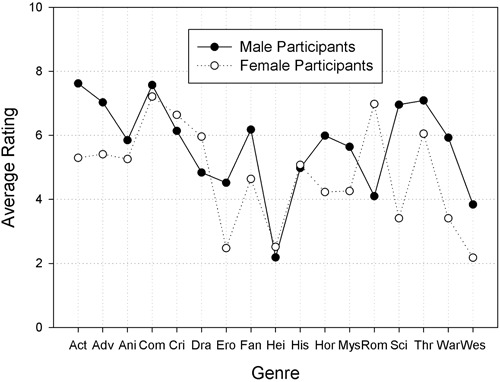
Results of Study 2: Average ratings from 80 males and 80 females participants who indicated their preference for 17 movie genres on a rating scale with 11 ticks ranging from 0 (not at all) to 10 (extremely). Short-hands on the x-axis are the same as in Figure 1